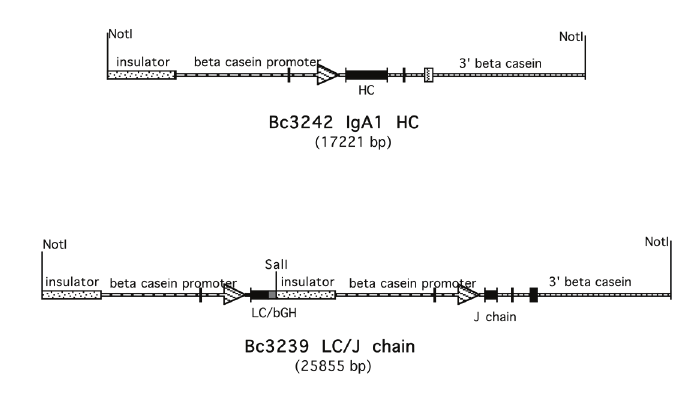
Supplementary Figure 5. Micro-injection Fragments BC3239 LC/J, BC3242 HC . The fragments for mi- croinjection were isolated from the prokaryotic SuperCos vector by digesting the plasmids with restriction enzymes that flank the inserts. NruI, which cuts the SuperCos plasmid was also used. The Bc3239 LC/J chain and BC3242 HC were both digested with NotI, NruI, and the expression constructs were isolated by gel electrophoresis from the prokaryotic SuperCos fragments.